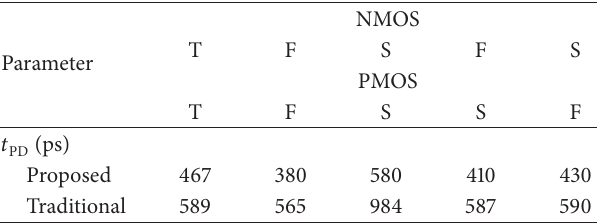
Table 4: Effect of process variation on the delay of the proposed and the traditional